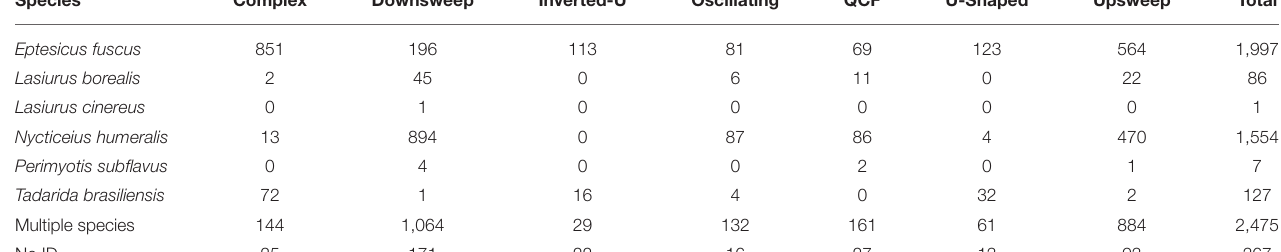
TABLE 1 | Number of in-flight social calls, by species and call type, recorded at the UNCG Wetlands, Greensboro, NC, from March 15th 2017 to June 30th, 2018. Species